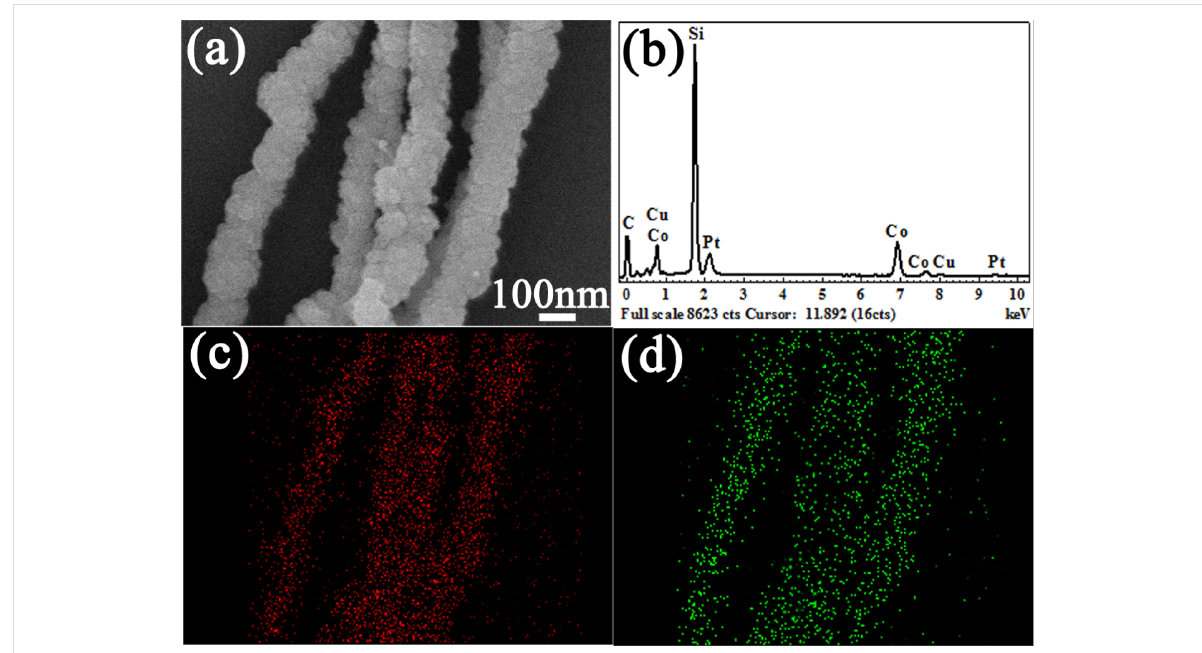
Figure 4: (a) SEM image and corresponding (b) EDS spectra of bimetallic Co–Cu nanowires, and elemental mapping profiles of (c) Co and (d) Cu.